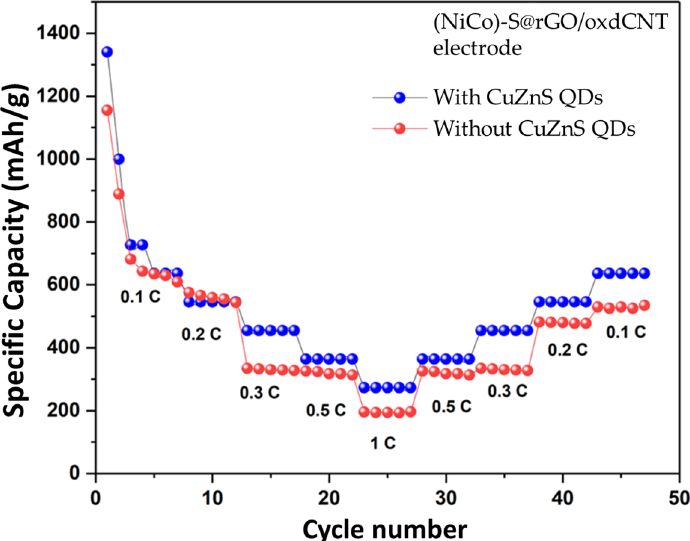
Figure 13. The rated capacity of Li–S batteries with and without CuZnS QDs decorated (NiCo)–